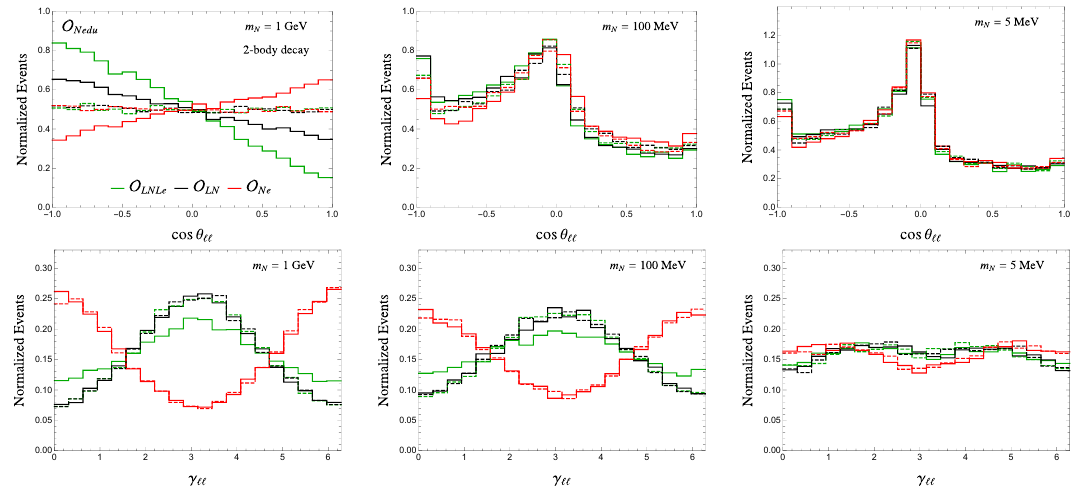
Figure 9 . Smeared cos θ ‘‘ distributions (upper panels) and γ ‘‘ distributions (lower panels) for the production operator O Nedu in the ¯ N rest frame from two-body B decay for the three decay operators: O LNLe (green), O LN (black), O Ne (red). Solid (dashed) lines are for a DF (MF) ¯ N .